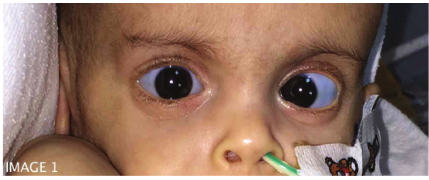
Figure 1: An image of the patient to demonstrate the blue sclera and left eye esotropia.